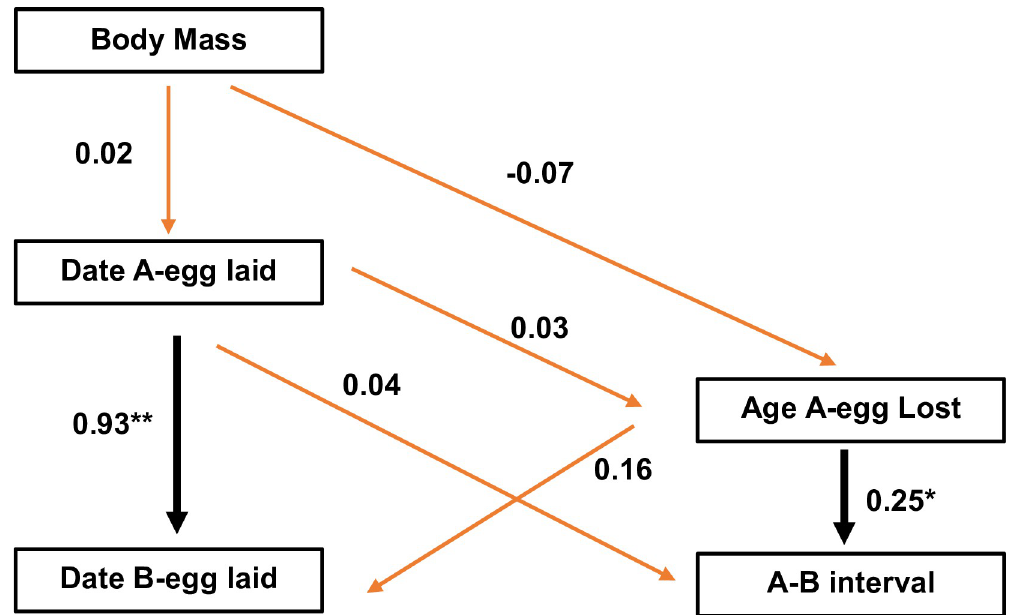
Fig 5. Correlations between the body mass of the female, dates of laying for A- and B-eggs, the laying interval (A-B interval) and the age at which the A-egg was lost. Significant correlations are shown with bold lines ( �� P < 0.001; � P < 0.05).